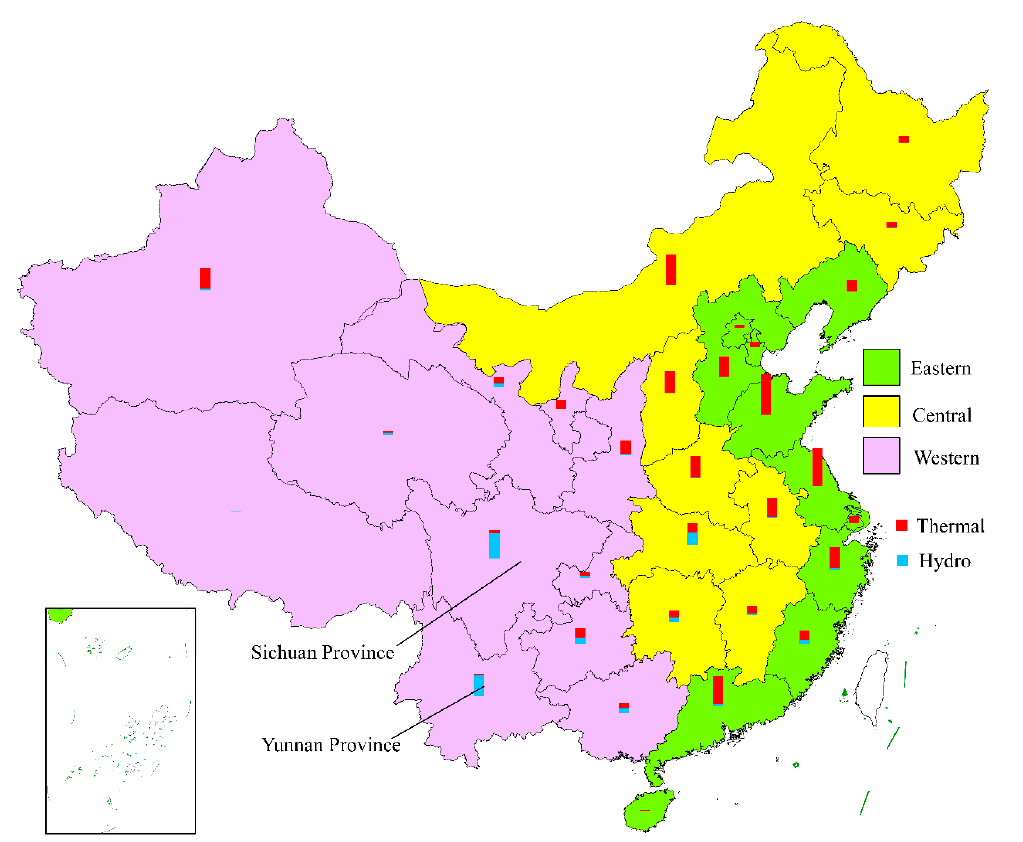
Figure 6. Distribution of thermal and hydropower generation in Eastern (green), Central (yellow), and Western (purple) China in 2017 (data source: [31]). Int. J. Environ. Res. Public Health 2020 , 17 , x